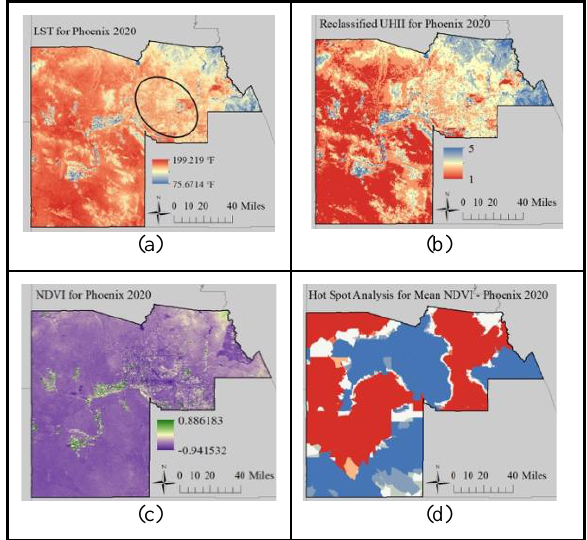
Figure 6. LST (a), UHII (b), NDVI (c), and NDVI hot spots (d) maps for Maricopa County, AZ for June, 2020.